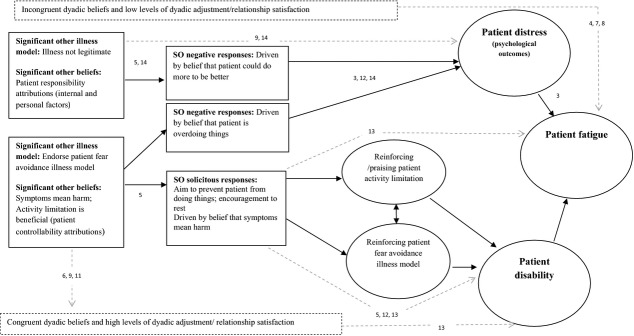
Proposed interpersonal processes involved in symptom maintenance and perpetuation in CFS/ME. Note. SO = significant other. Numbers indicate the study source. 1 = Ax (1999); 2 = Ax et al. (2002); 3 = Band et al. (2014); 4 = Blazquez et al. (2012); 5 = Brooks, Daglish, et al. (2013), Brooks, King, et al. (2013); 6 = Butler et al. (2001); 7 = Goodwin (1997); 8 = Goodwin (2000); 9 = Heijmans et al. (1999); 10 = Kelly et al. (1999); 11 = Richards et al. (2006); 12 = Romano et al. (2009); 13 = Schmaling et al. (2000); 14 = White et al. (2006).